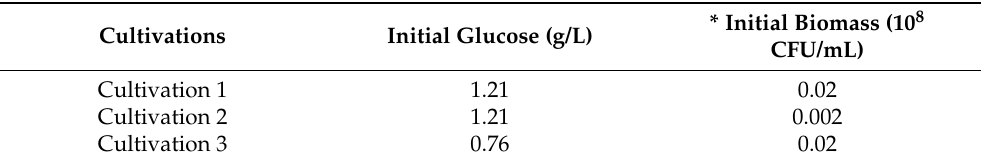
Table 1. Initial concentrations of glucose and biomass (initial levels of Lactiplantibacillus plantarum A6 and Lacticaseibacillus rhamnosus